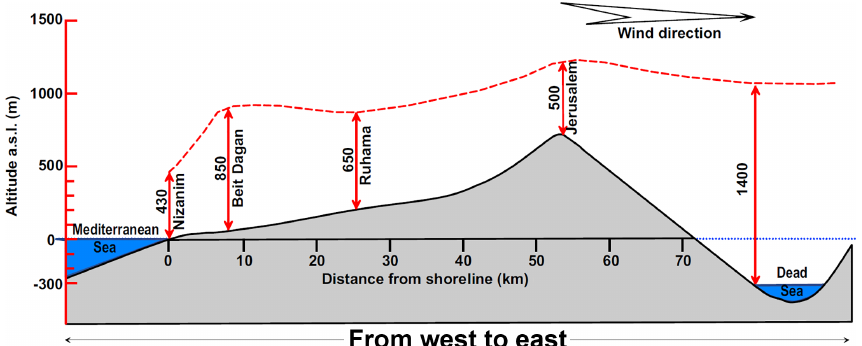
Figure 11. Schematic description of the lateral variation of the mixing layer depth (ma.s.l.) from the Mediterranean Sea to the Dead Sea (from Dayan et al., 1988; ©American Meteorological Society; used with permission).